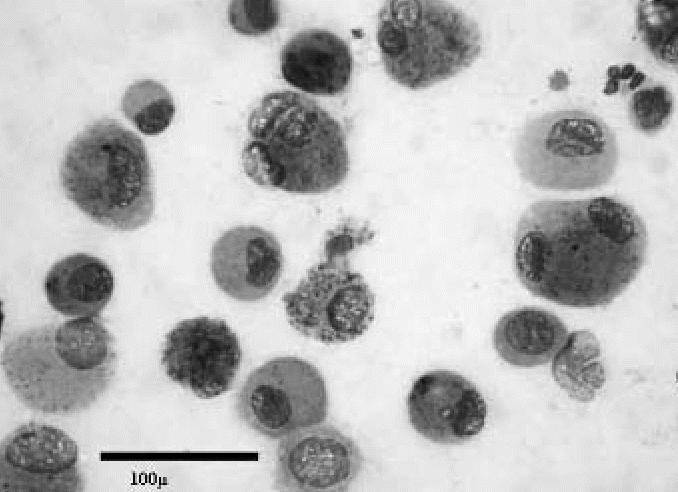
Cytology of BAL sample from an exposed subject showing a predominance of large macrophages (May-Grunwald-Giemsa). Bar = 100 μm.